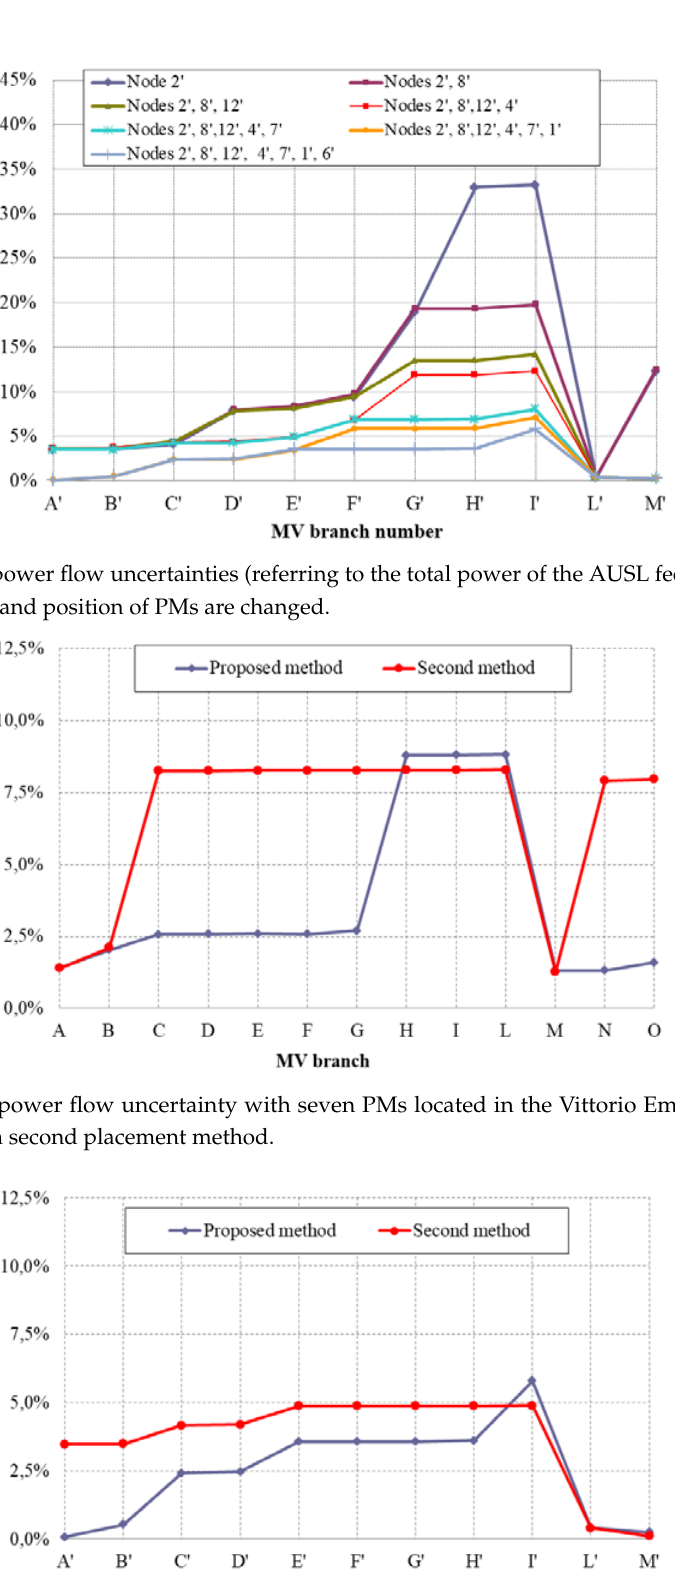
Figure 8. Branch power flow uncertainty with seven PMs located in the AUSL feeder: comparison with a second placement method.